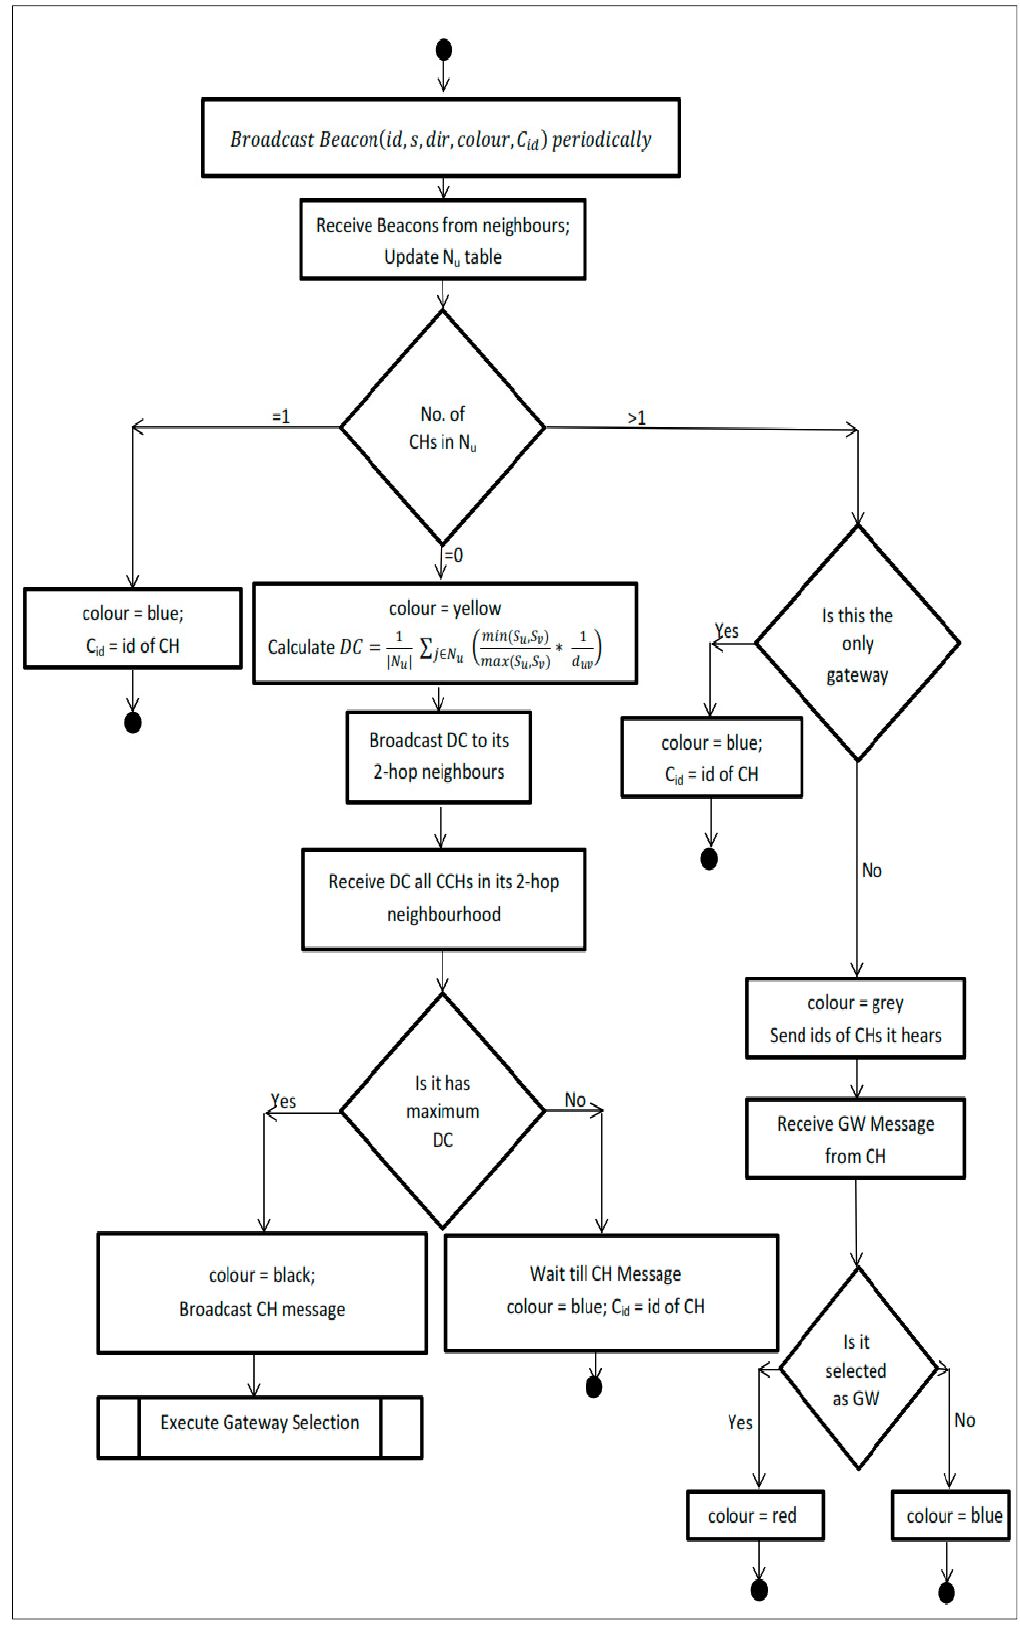
Figure 5. Cluster formation algorithm.